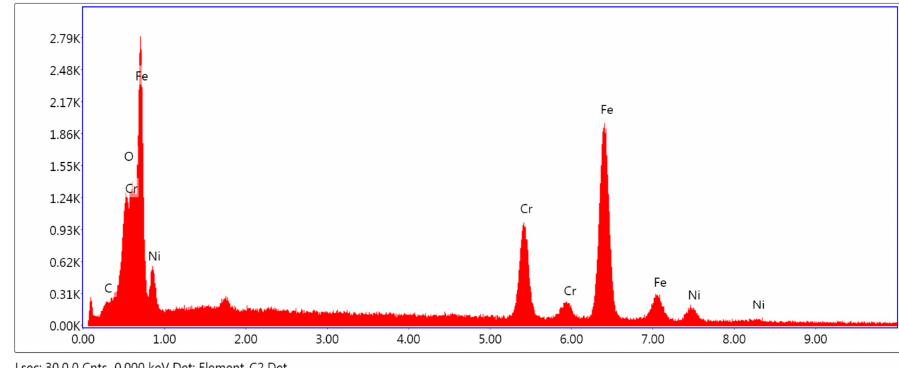
Figure 9. Energy dispersive X-ray spectroscopy (EDS) spectrum of precipitate. Table 4. Composition of precipitates.